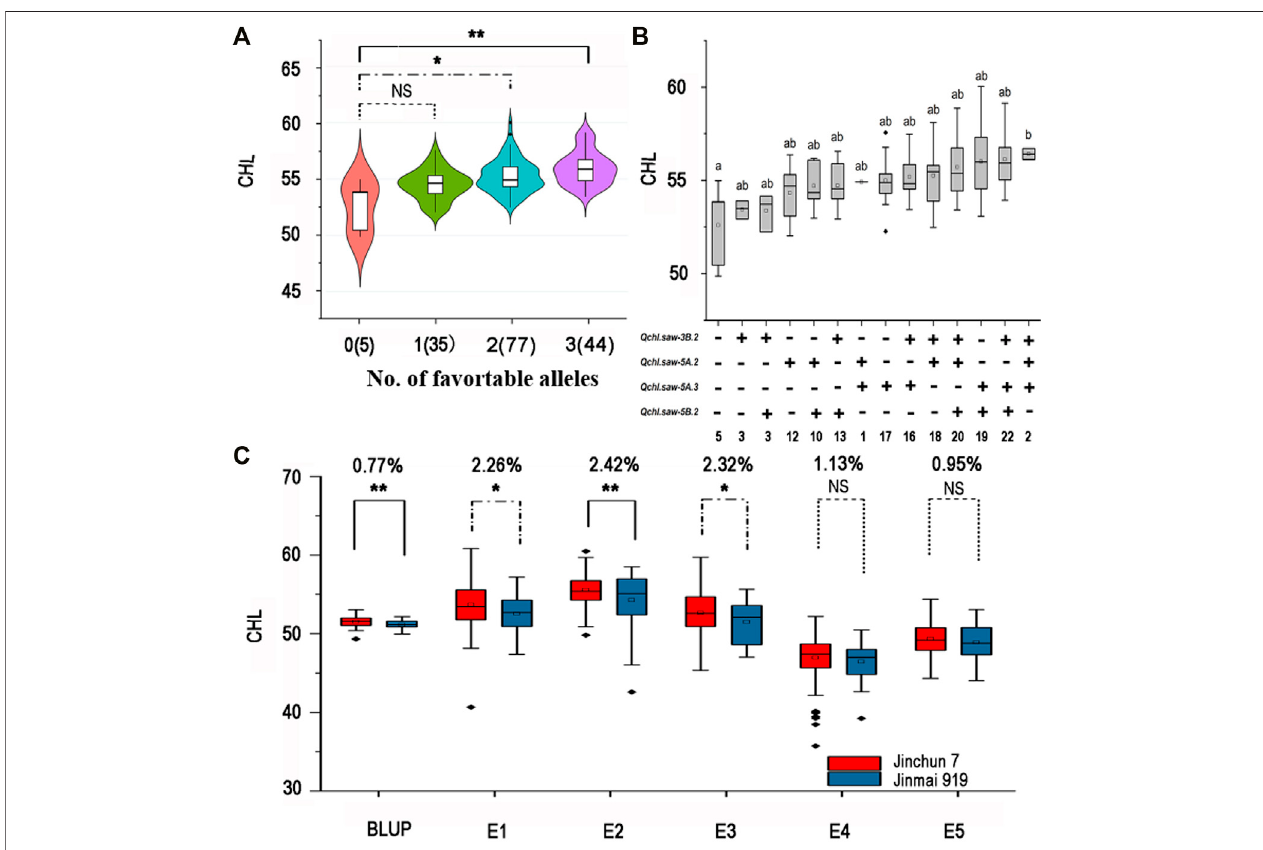
FIGURE 2 | Additive effects and validation of major QTL. (A) Relationship of numbers of favorable alleles and chlorophyll content in the DJ population. (B) Linear regressionsbetweentheadditiveeffectsofQTLandchlorophyllcontentintheDJpopulation.Numbersoflinescarryingthecorrespondingnumberoffavorableallelesare shown in brackets. The letter above the bars indicates comparison results at the signi fi cant level 0.05 and respectively. “ + ” and “ − ” represent lines with and without the favorable alleles. (C) Validation of Qchl.saw-3B.2 in JJ population. * and ** represent signi fi cance at p < 0.05 and p < 0.01, respectively. NS represents not signi fi cant.